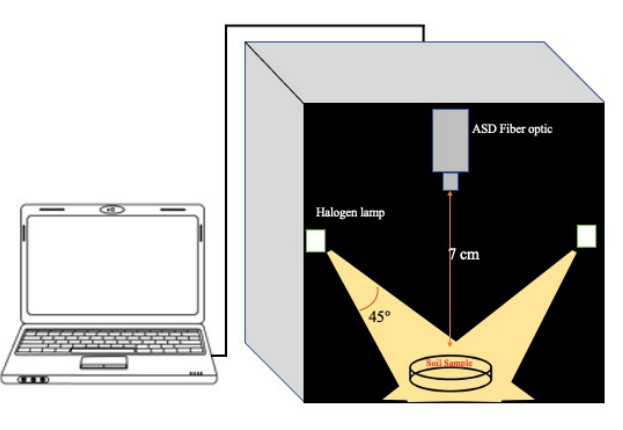
Figure 2. vis–NIR spectra measurement